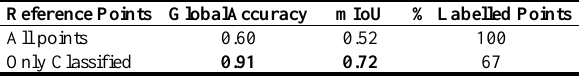
Table 4 . Back-projection results for 2_OSA.